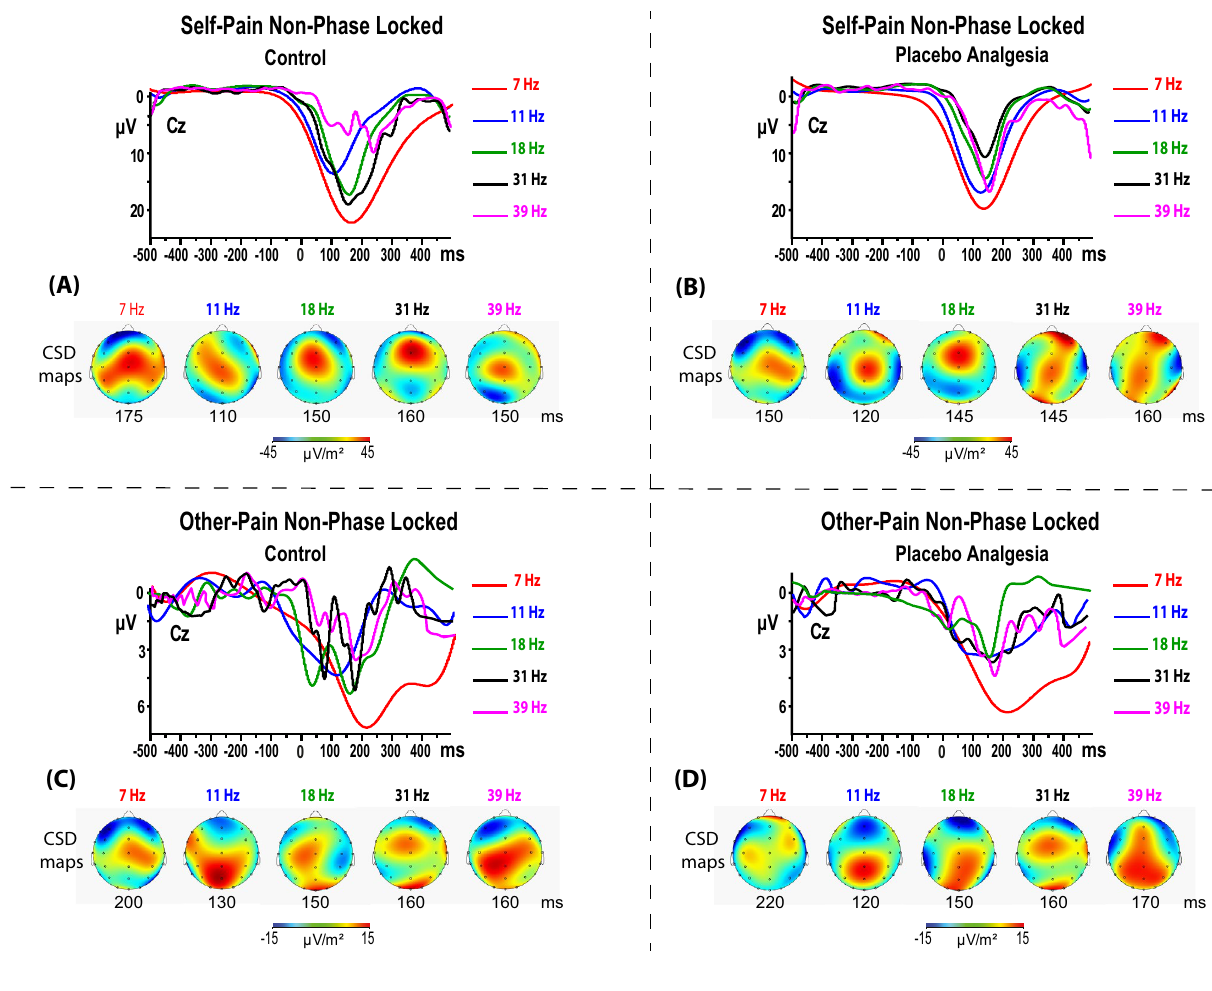
Figure 3. Wavelet-extracted o scillatory amplitude waveforms at frequency layers of 7, 11, 18, 31, and 39 Hz from the averaged wavelet-transformed single trials of the self-pain (upper-quadrant) and other-pain (lower- quadrant), respectively, for Control ( A , C ) and Placebo Analgesia ( B , D ) treatments (painful electric-train onset at time 0 ms). Color current source density maps (µV/m 2 ) are reported at the bottom for each frequency of interest (7, 11, 18, 31, and 39 Hz) and the time corresponding to each maxima amplitude for each